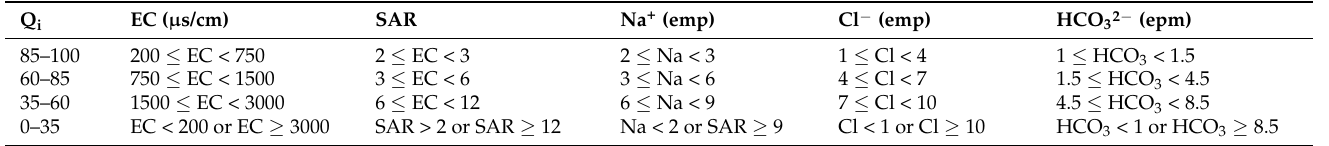
Table 2. Limiting values for the variables used in the computation of quality measurement